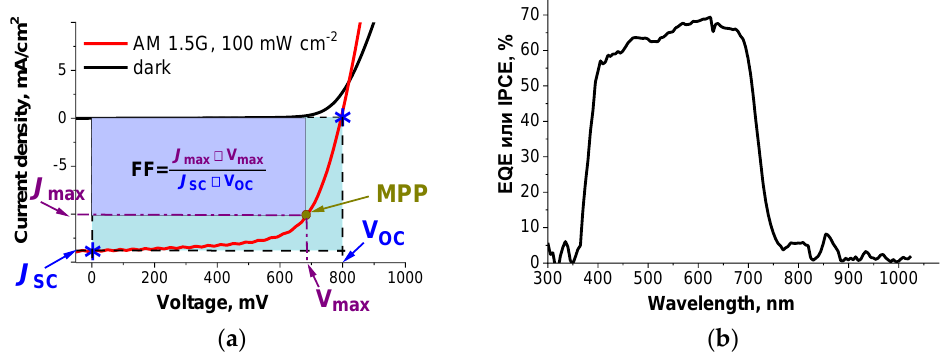
Figure 5. ( a ) Current – voltage curve and ( b ) the external quantum efficiency (EQE) spectrum of an organic solar cell.